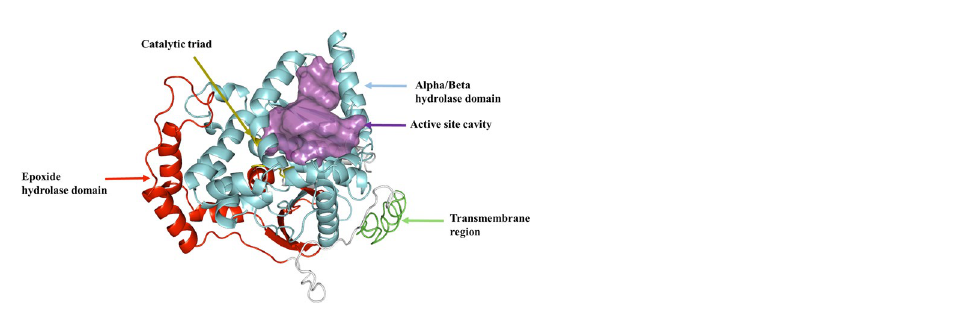
Figure 3. Phylogenetic analysis of JHEH and JHEH-like protein homologs from different insect species. The phylogenetic tree was generated by MEGA 6.0 using the amino acid sequences from Bombus impatiens